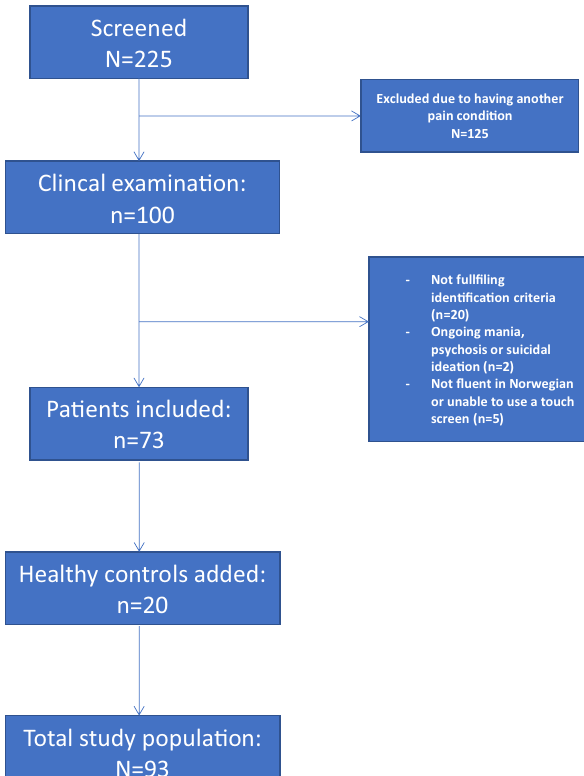
Figure 1. Flow of participants throughout the study from screening to